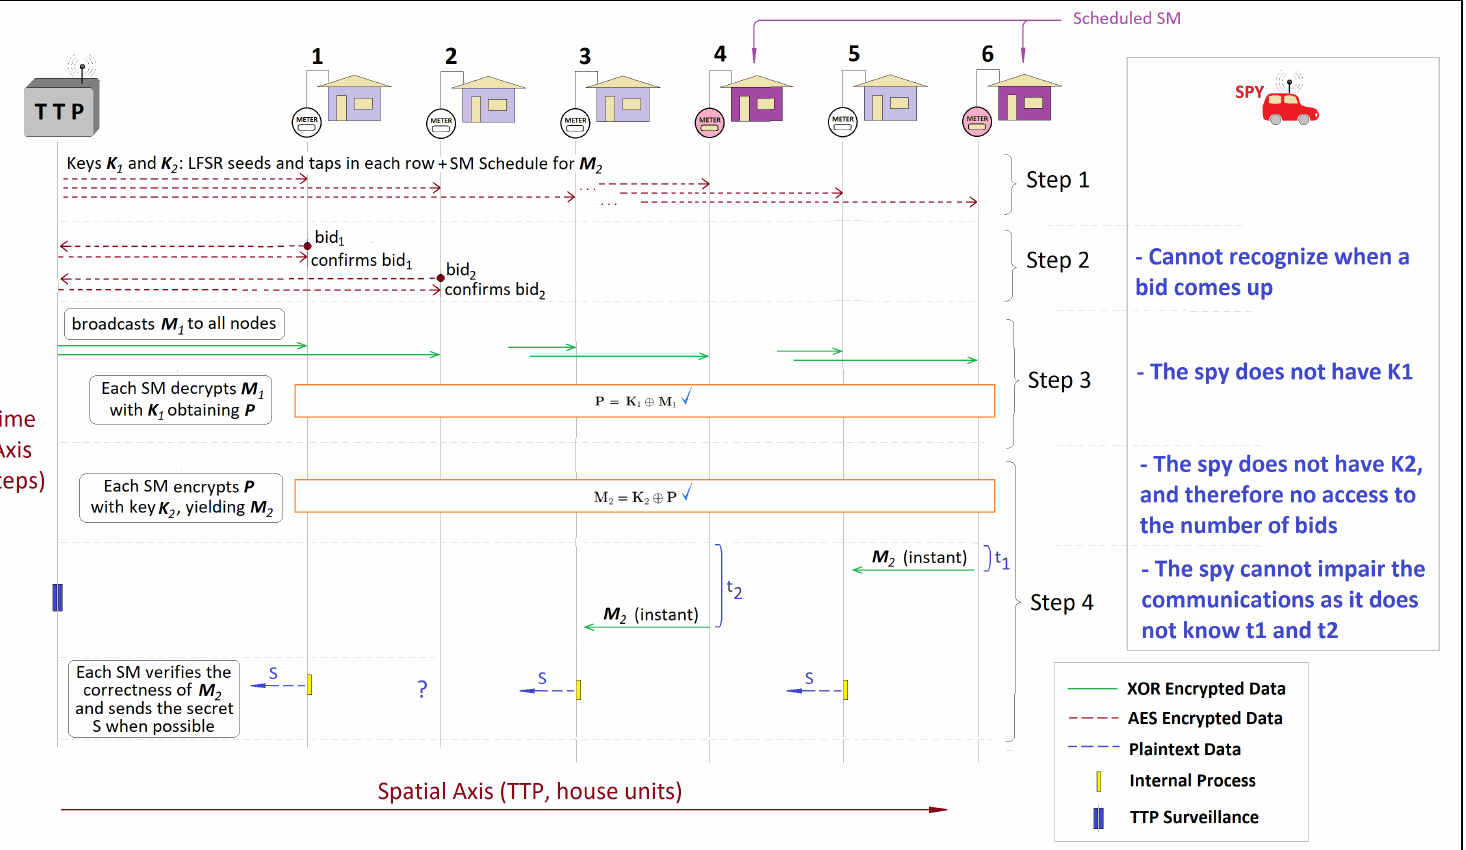
Figure 4. Sequence of stages in the proposed framework from the standpoint of a spy: Due to the sequence of stages, the spy can neither infer how many orders are posed nor of which type they